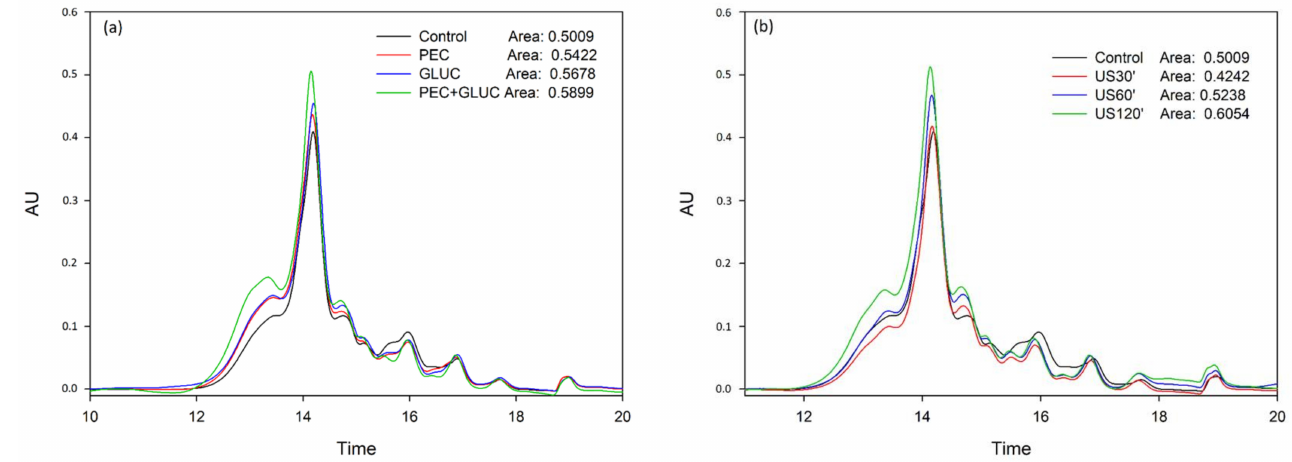
Figure 1. Mass distribution of the tannins released from lees analyzed by SEC in the elution time comprised between 12 and 20 min. ( a ) Comparison of tannins composition released with the enzyme treatments. ( b ) Comparison of tannins composition released with the US treatments. This figure was made in SigmaPlot 10.0.